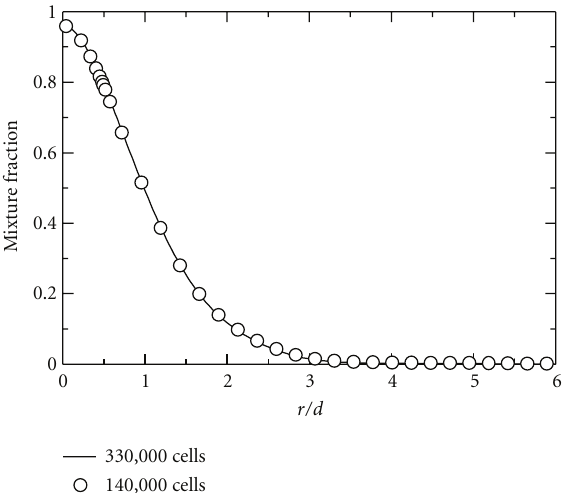
Figure 5: Radial mixture fractions predicted with di ff erent grids at x/d = 10.